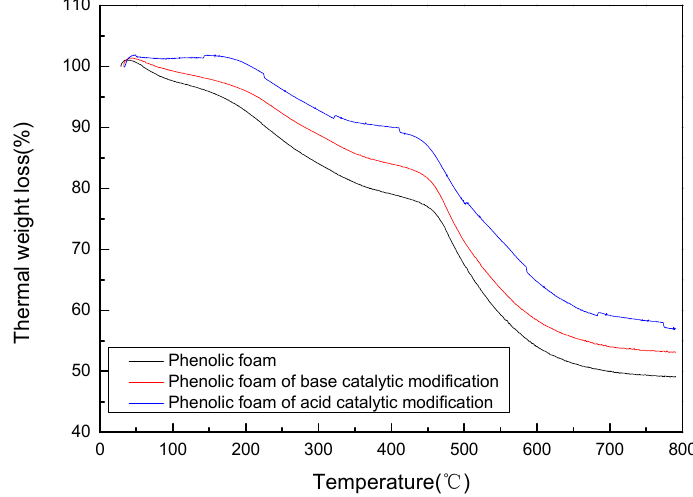
Figure 4. Thermogravimetric curve of phenolic foam and modified phenolic foam. Table 3. Thermogravimetric data analysis of phenolic resin and modified neophenol resin.